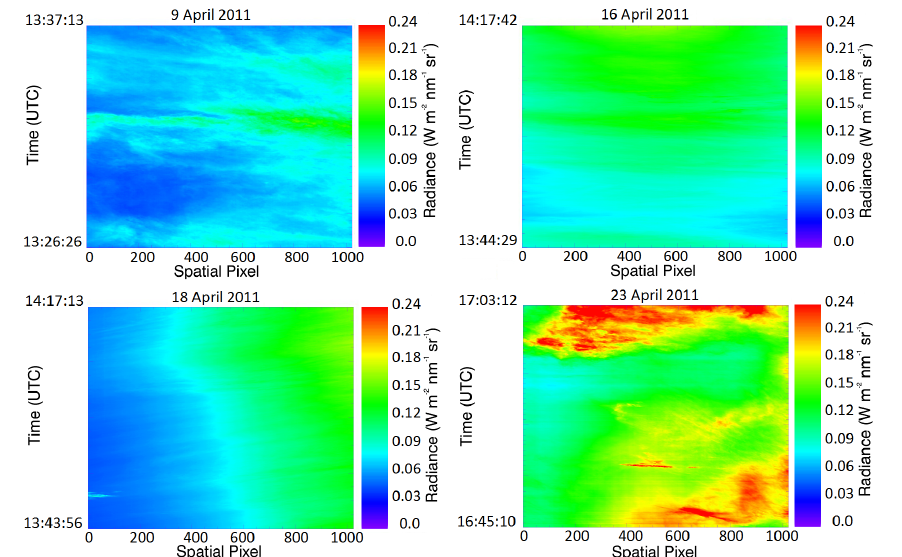
Fig. 8: Two-dimensional images of the evaluated AisaEAGLE radiance measurements at 530nm with the measured I ↓ (Wm -2 nm -1 sr -1 ) given in colour scales.